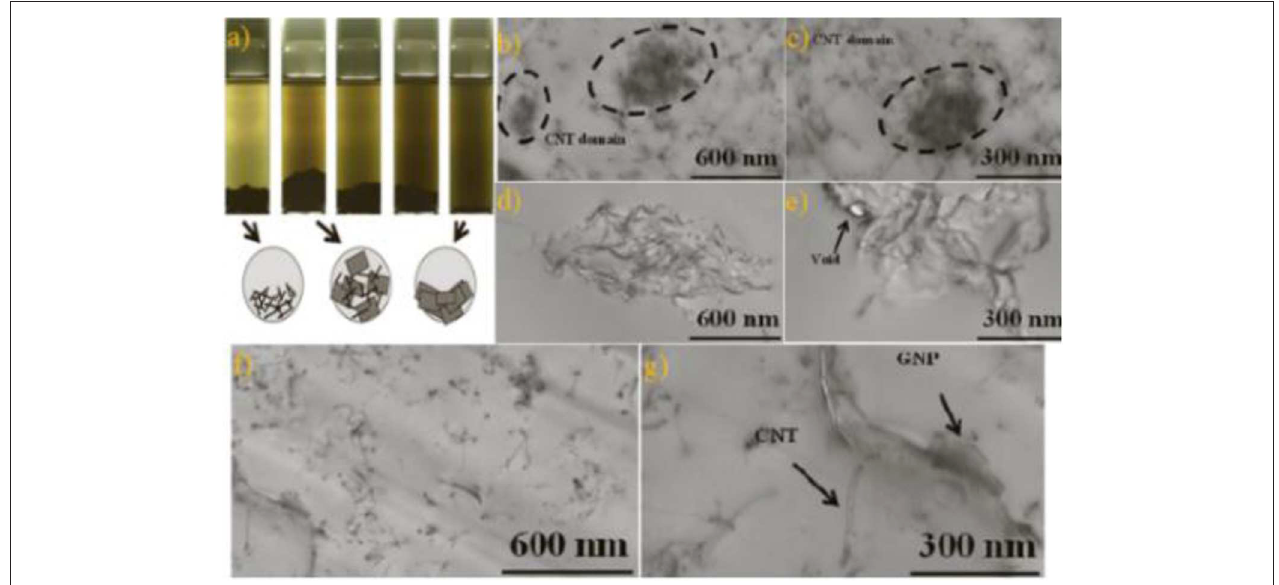
8:2, CNT:GNP 4:6, CNT:GNP 2:8, and GNP = = = 8:2/epoxy composite SEM diagrams. CNT, carbon nanotube; GNP, graphene nanoplate; =